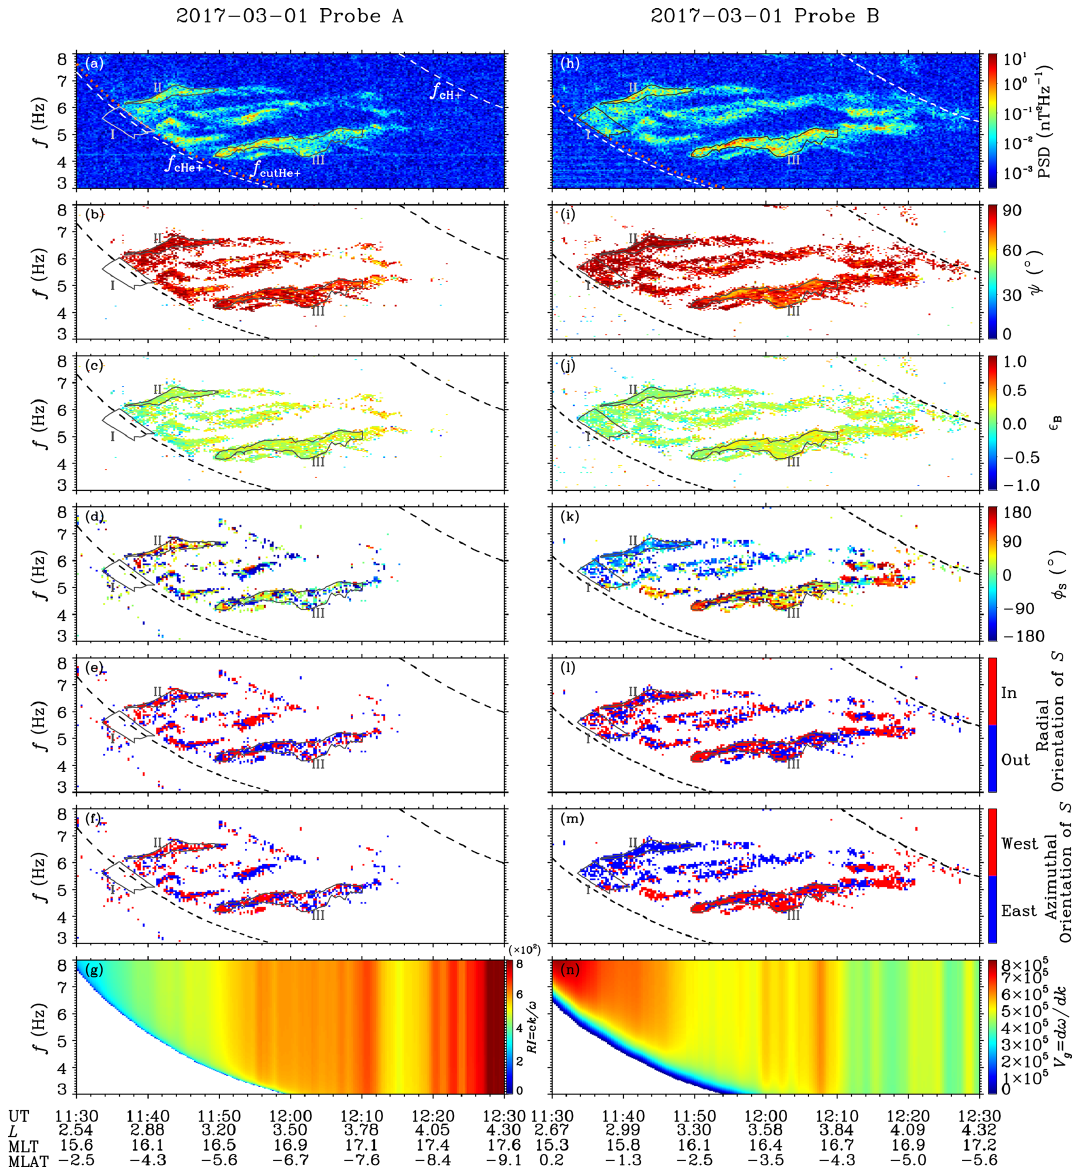
Figure 2. Time–frequency distributions of wave properties. (a, h) Magnetic field power spectral density (PSD). The dotted red lines mark the lowest boundary (potential helium cutoff frequencies f cutHe + ) of the visible waves. The dashed lines trace the local H + and He + gyrofrequencies. The grey closed curves mark the three selected regions in time–frequency domain. (b, i) Wave normal angle ψ (unifying the two field-aligned orientations). (c, j) Magnetic ellipticity (cid:15) B . (d, k) Azimuthal angle of the Poynting flux φ S . Angle 0 ◦ represents away from the Earth. The angle increases in a counterclockwise direction. (e, l) Radial orientation of the Poynting flux. (f, m) Azimuthal orientation of the Poynting flux. (g) Refractive index (RI) for the MS mode (at ψ = 90 ◦ ). (n) Group velocity V g for the MS mode (at ψ = 90 ◦ ).